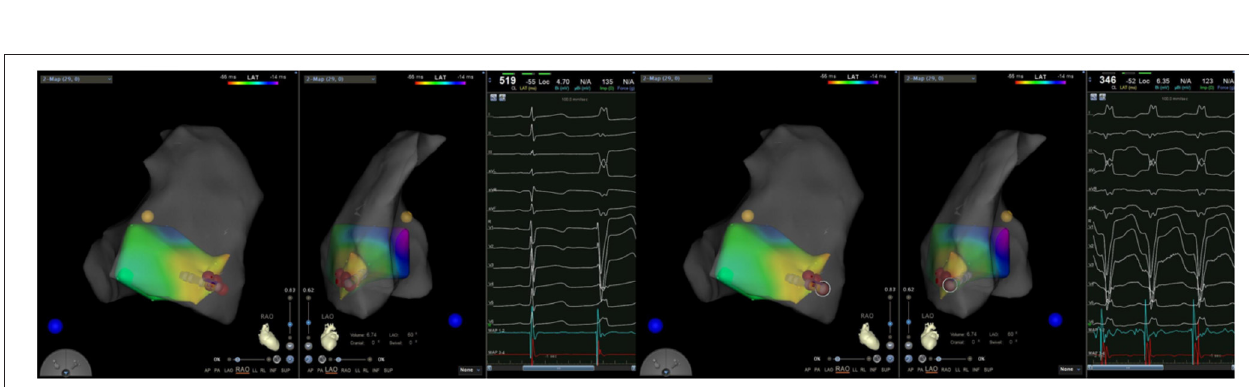
FIGURE 2 | (Left) Activation mapping; (Right) Pace mapping is used to verify that the morphology of premature ventricular contraction is consistent with surface electrocardiogram.